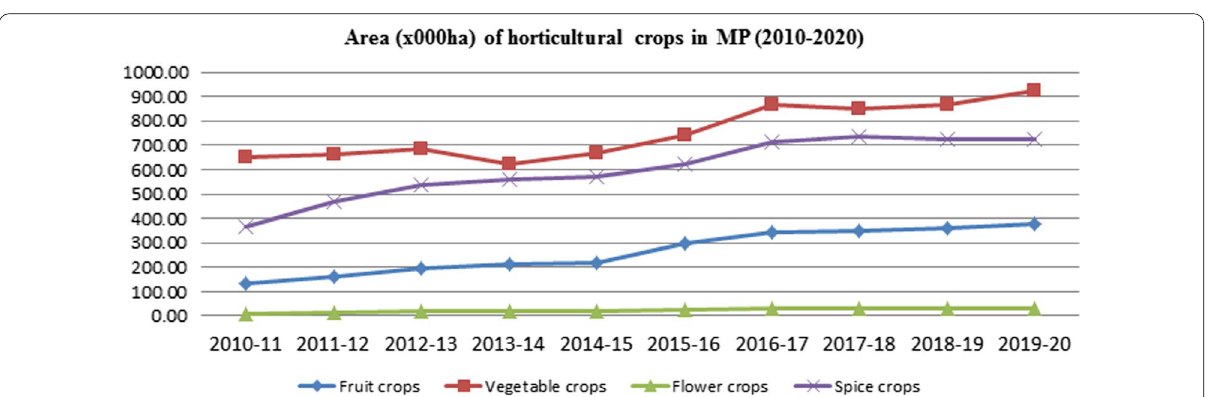
Fig. 13 Decadal growth in the area of fruit, vegetable, flower and spice crops in Madhya Pradesh during 2010 to 2020 indicate a rise in the cultivated area of the horticultural